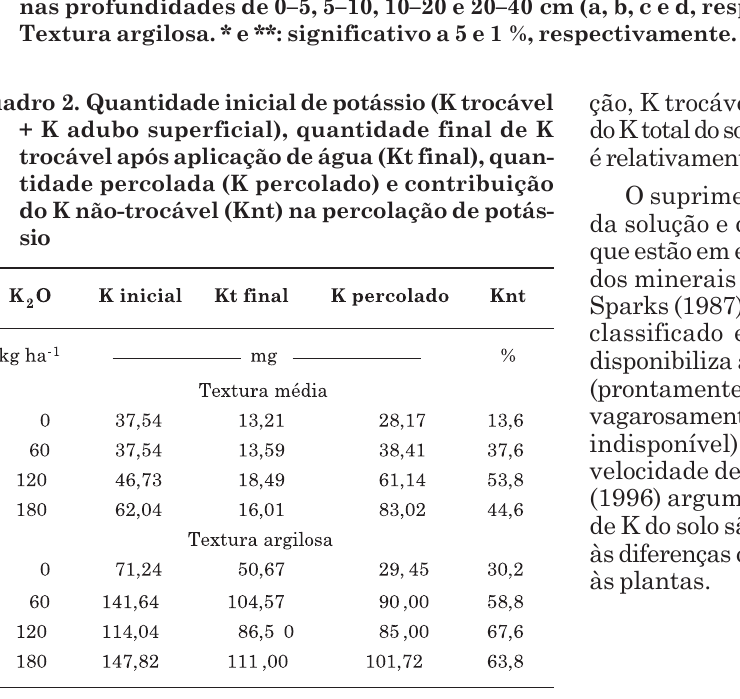
O após aplicação de água, 2